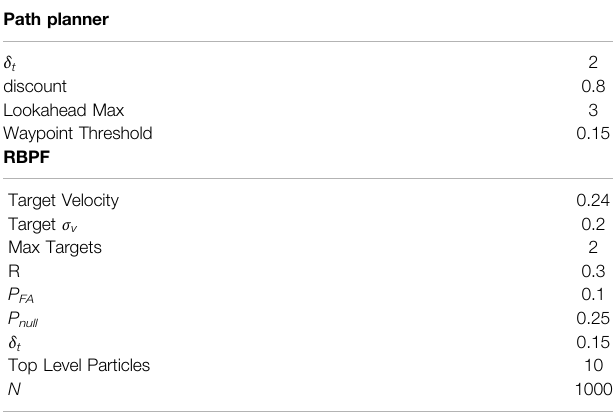
TABLE1| Parameters usedbythePathPlannerandtheRBPFtomaximizetarget certainty given our hardware costraints. Path planner